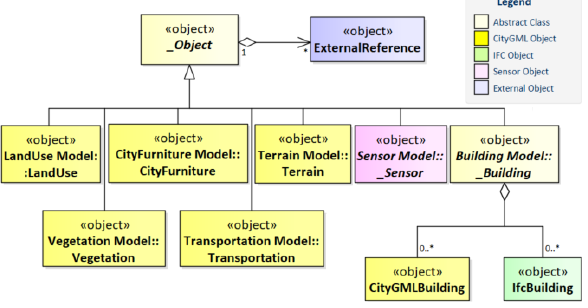
Figure 1. UML diagram for conceptual design of PIM.